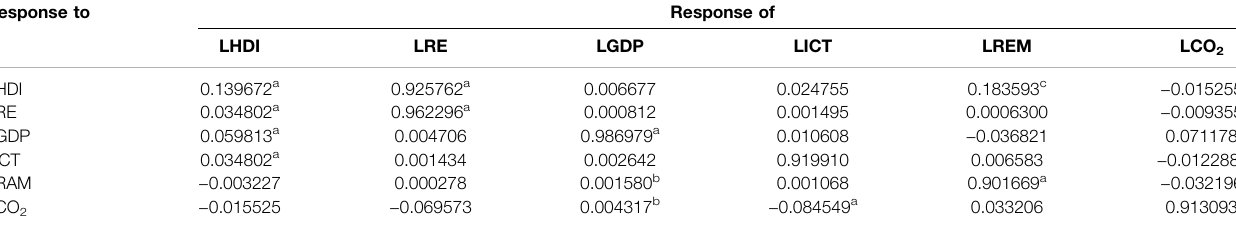
TABLE 5 | Panel VAR